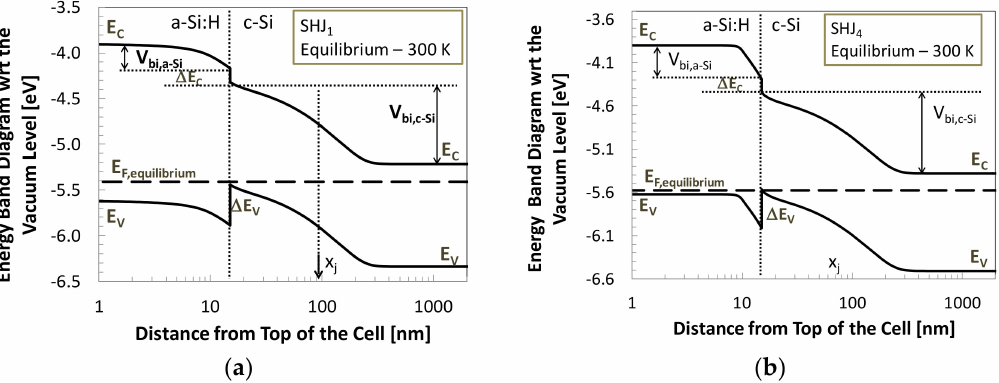
Figure 2. Simulated band diagrams at equilibrium for ( a ) cell SHJ 1 [35] and ( b ) cell SHJ 4 .